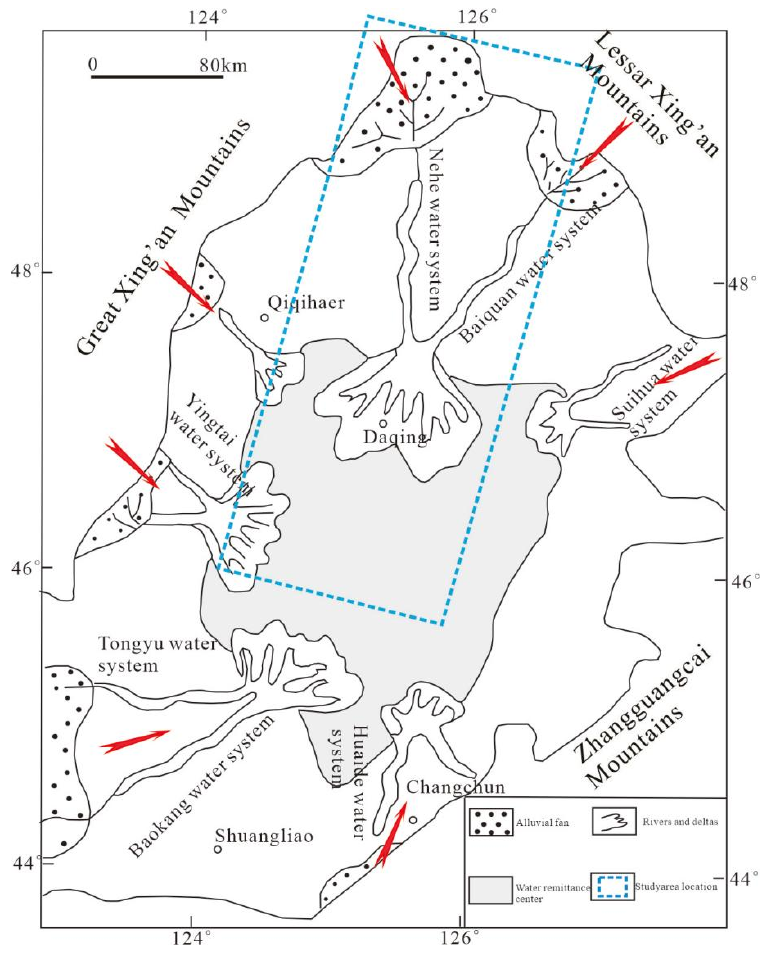
Figure 12. Distribution of water systems in the Songliao Basin.